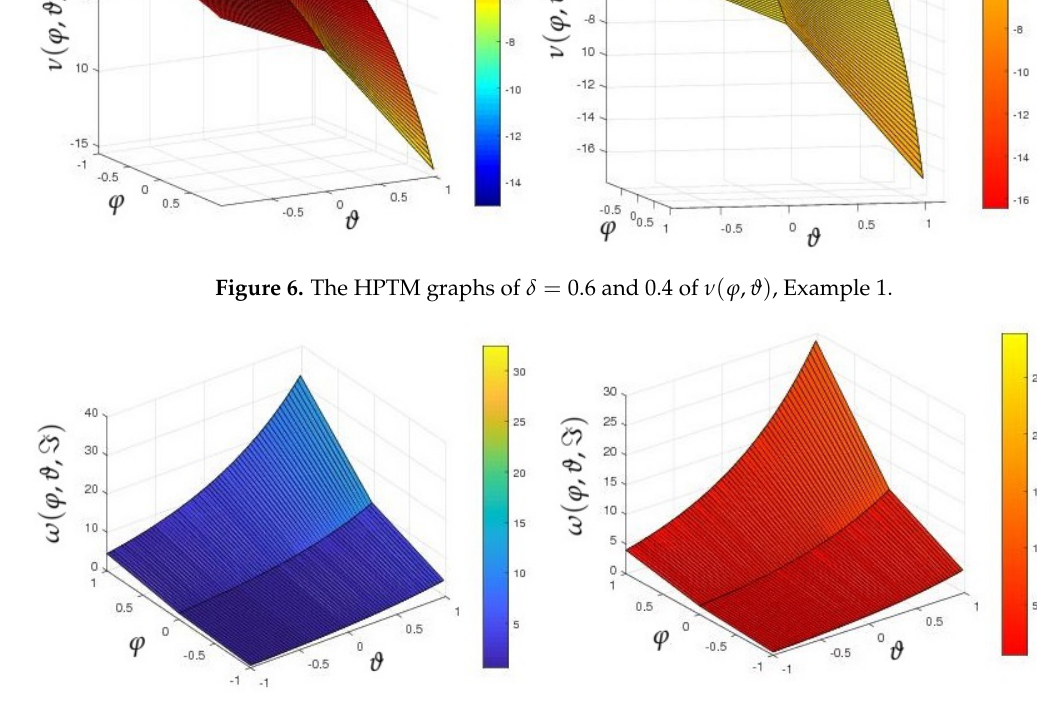
Figure 7. The HPTM graphs of δ = 1 and 0.8 of ω ( ϕ , ϑ ) , Example